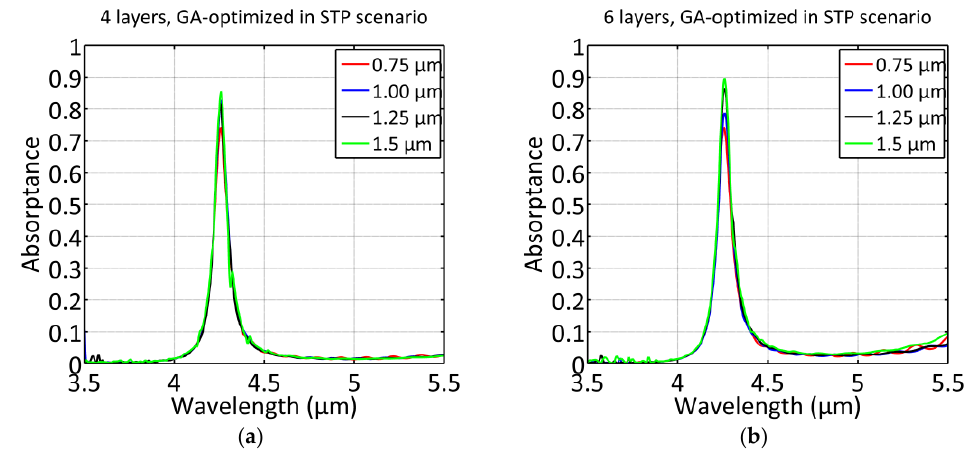
Figure 4. Spectral response of the STP structures (TE) for four ( a ) and six layers ( b ), respectively. The thicknesses were obtained by the GA optimization process featuring slab-TP structures.